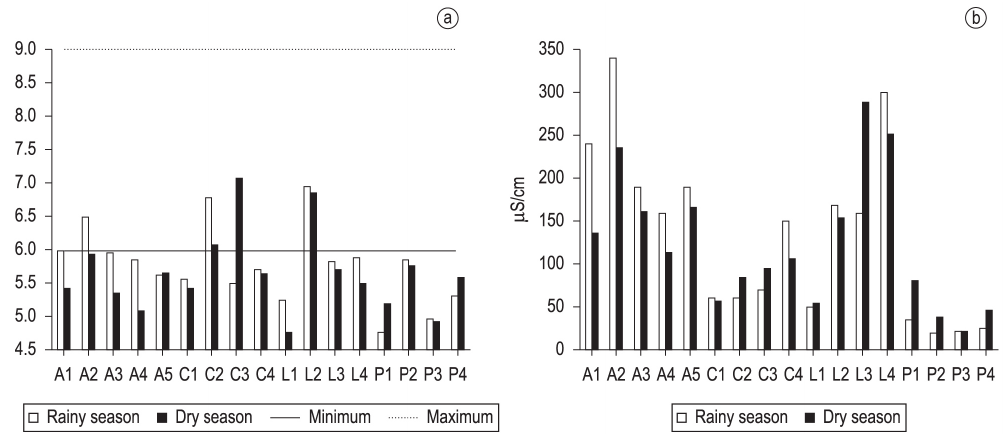
Figure 3. Variation of pH (b) and electric conductivity (a) in Araquá, Capivara, Lavapés and Pardo Rivers in rainy and dry season and rivers classification limit (class 1,2, 3 and 4) according to CONAMA